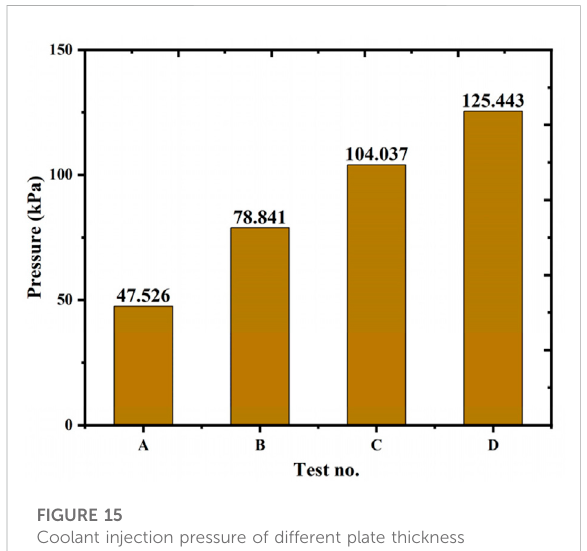
FIGURE 15 Coolant injection pressure of different plate thickness combinations. ( F =